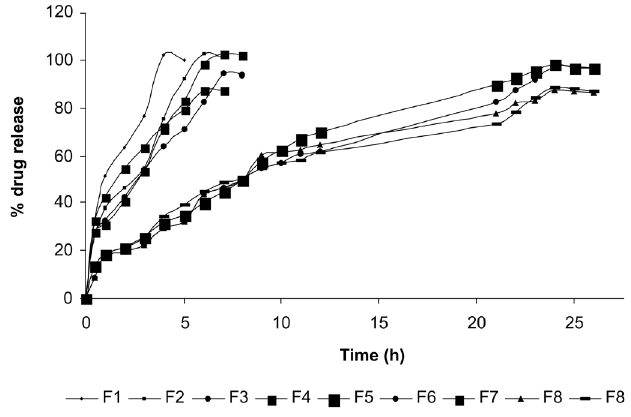
FIGURE 1 - Dissolution profile of sustained release formulations of metoprolol succinate pellets{Mean